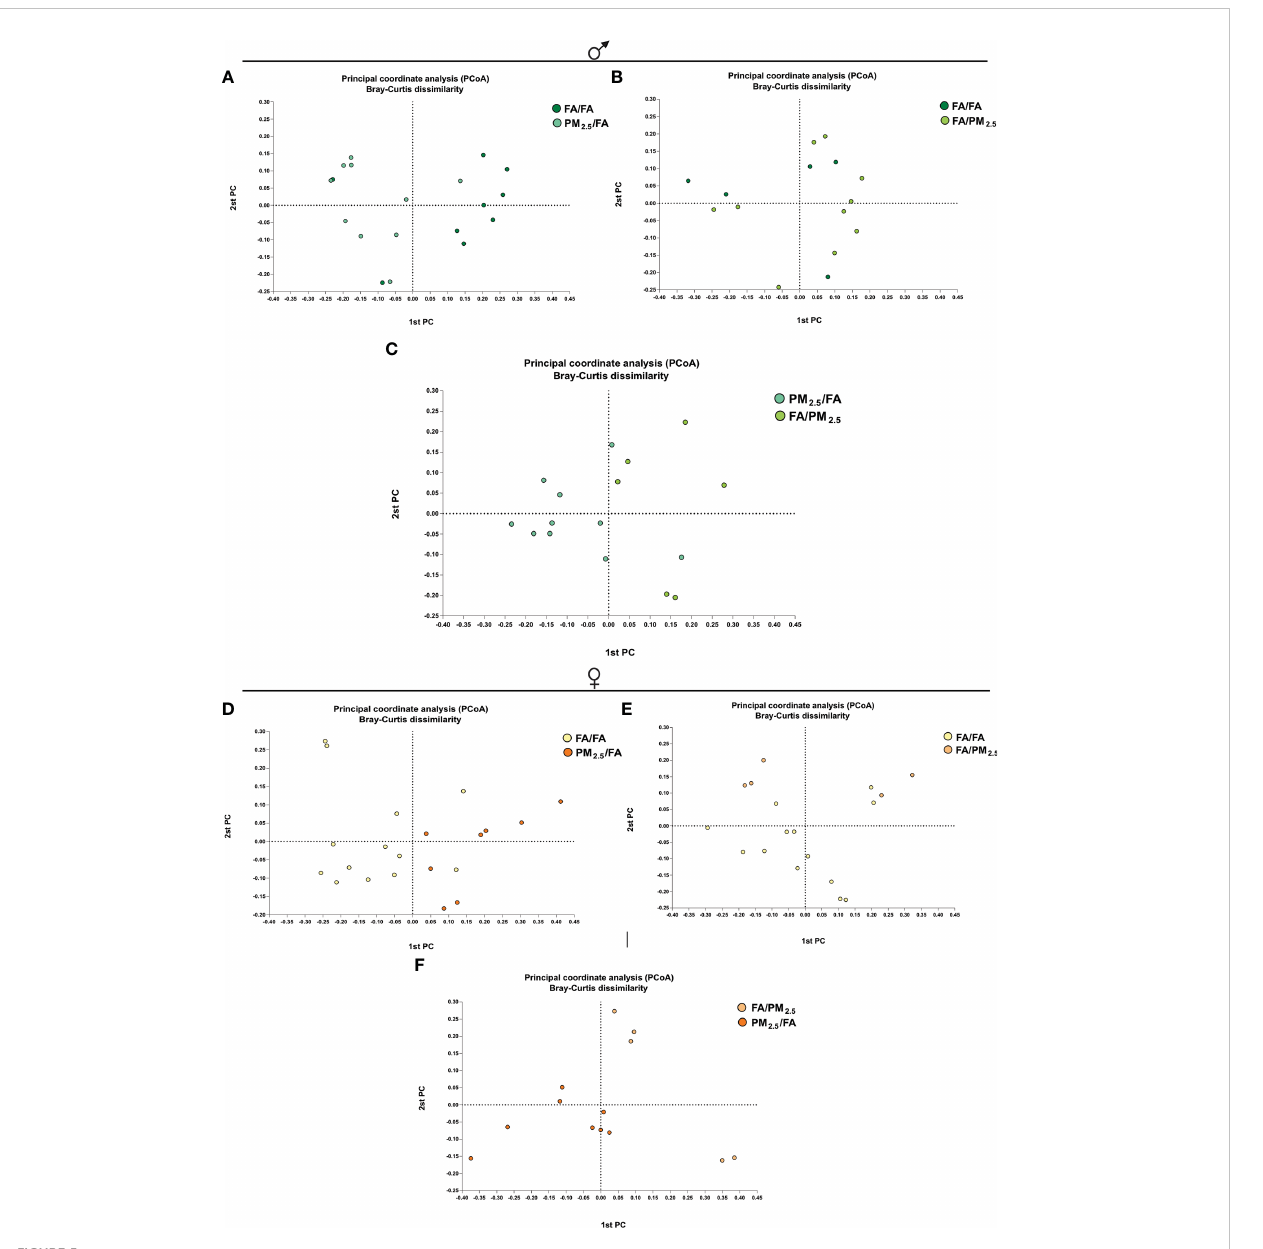
FIGURE 5 Principal coordinate analysis (PCoA) plot with Bray-Curtis dissimilarity. Ordination (PCoA) generated by using the Bray – Curtis dissimilarity metric sampled. Samples are colored according to the group. Male offspring (A, B) Bray-Curtis PCoA ordination. Results revealed that the FA/FA group displayed a spatial separation from PM 2.5 /FA but not from FA/PM 2.5 (PERMANOVA: p = 0.007 and p = 0.46, respectively) (C) PM 2.5 /FA group showed a spatial separation from FA/PM 2.5 (PERMANOVA: p = 0.004). Female offspring (D, E) Bray-Curtis PCoA ordination. Results revealed that the FA/FA group displayed a spatial separation from PM 2.5 /FA and FA/PM 2.5 (PERMANOVA: p = 0.001 and p = 0.030, respectively). (F) PM 2.5 /FA group showed a spatial separation from FA/PM 2.5 (PERMANOVA: p =